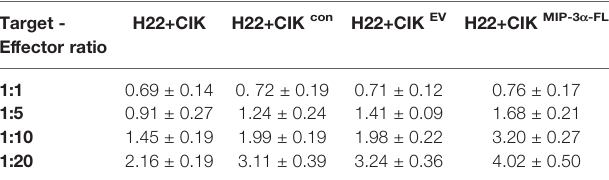
TABLE 4 | Comparison of CIK killing activity under different target - effector ratios